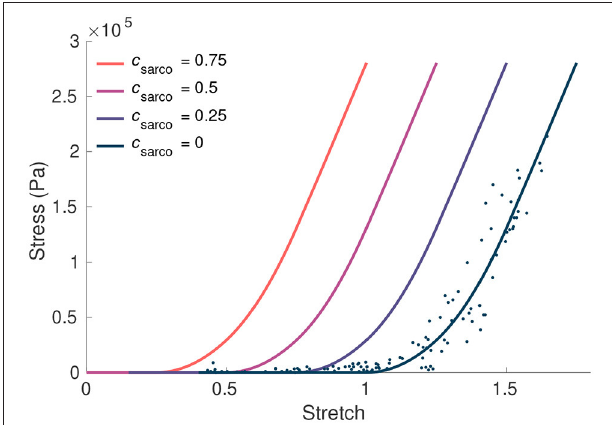
FIGURE 2 | The influence of c sarco on the intrinsic fibre stress-stretch relationship. Here we plot the stress from the fibre component of our model against the stretch in the fibres. The curve corresponding to typically developed muscle ( c sarco = 0) was obtained based on curves and data in Ross et al. (2018a). This was done through trigonometric polynomial and second-order piecewise polynomial fits to experimental data from Winters et al. (2011) (denoted by the